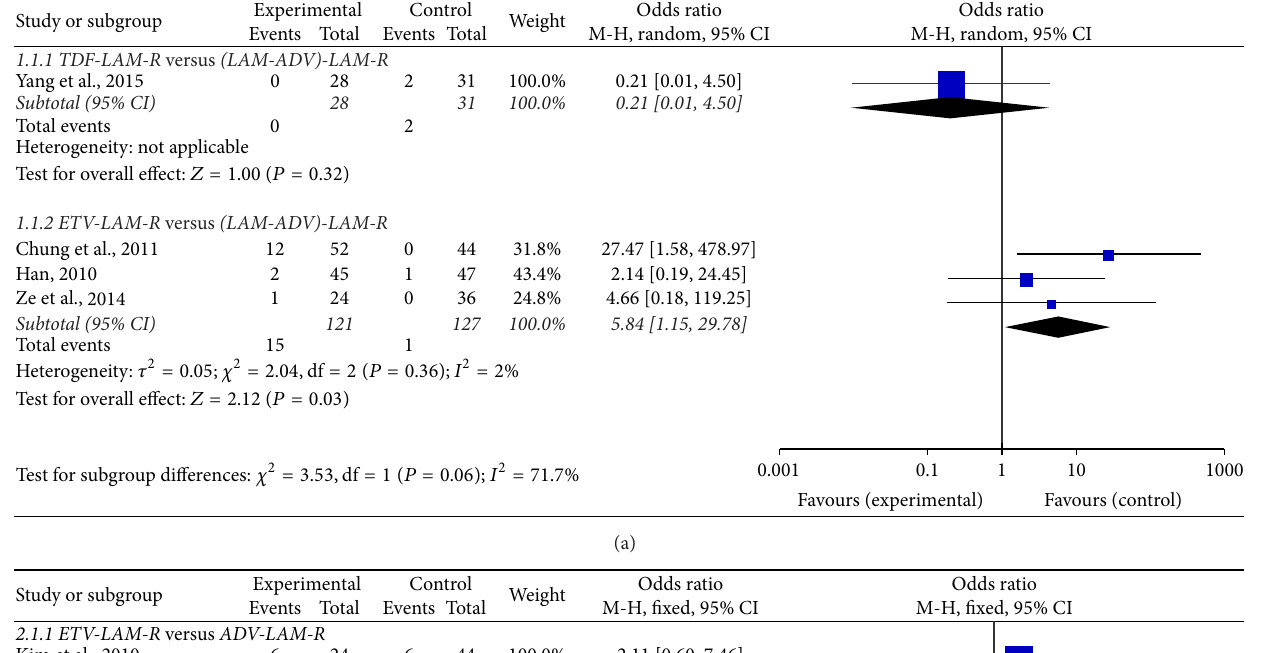
ranked first, second, and third for improving biochemical response, respectively, whereas ETV had the worst proba- bility of being ranked fourth. In addition, TDF, LAM/ADV, ADV, and ETV had the highest probability of being ranked first, second, third, and fourth for achieving HBeAg loss after 48-week treatment, respectively. Of note, ETV or ADV had a higher rate of virological breakthrough and genotypic resistance compared to LAM/ADV (22.9% versus